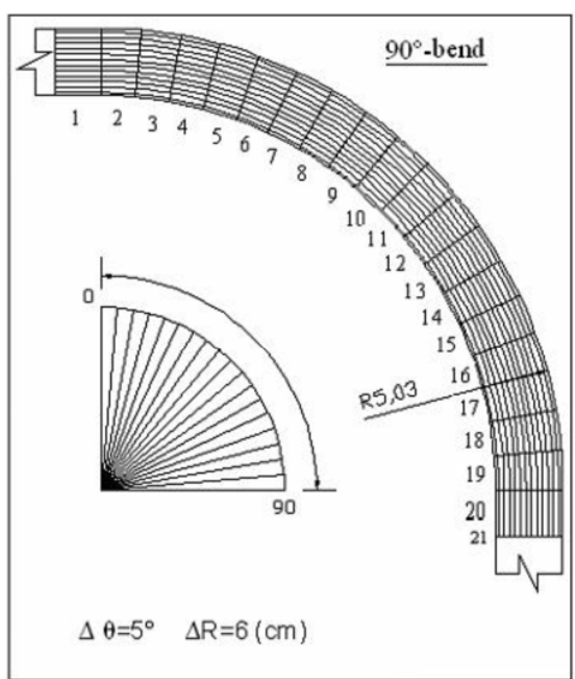
Fig. 7. Channel geometry and measured section of 900 - bend.